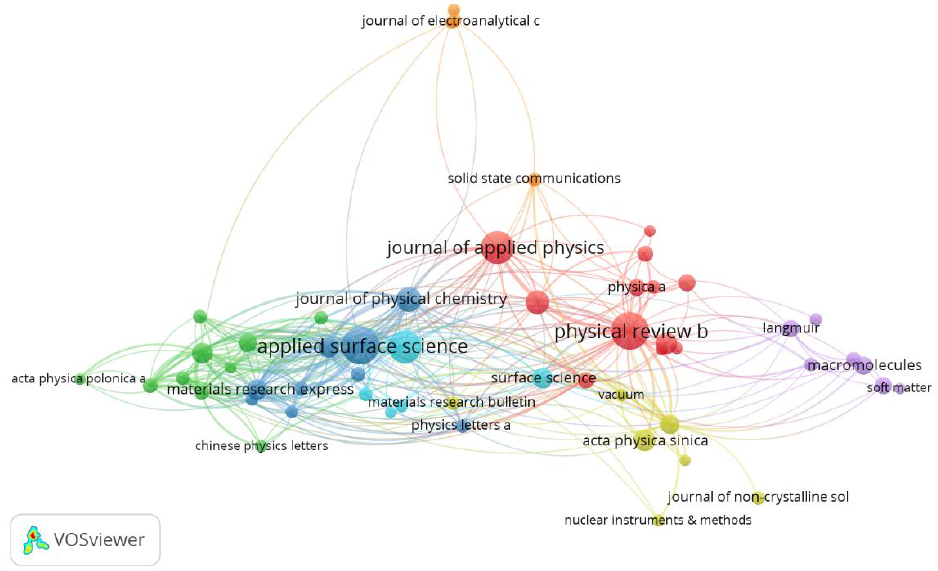
Figure 5. A map network showing citations of the leading journals in fractal theory of thin films .